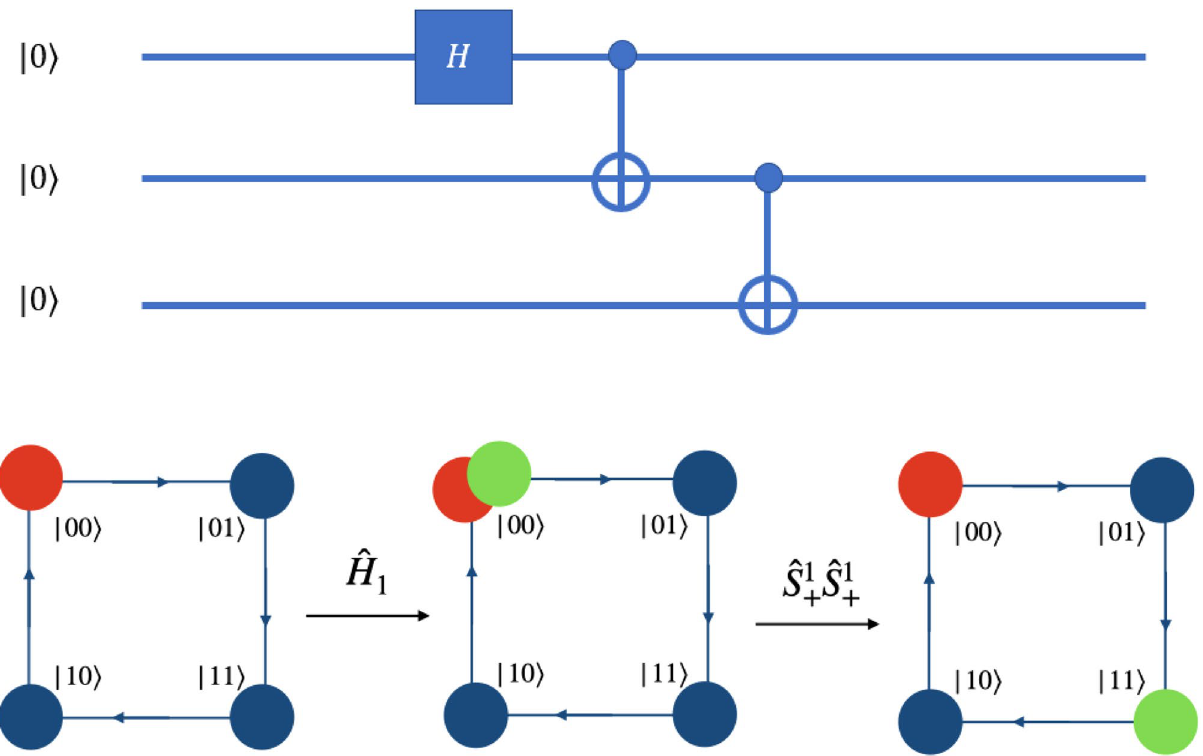
Figure 11. Quantum circuit to create GHZ-state on three qubit system and equivalent quantum walk scheme to obtain GHZ-state is illustrated. Red circle represents real particle. Here the QW-based scheme is more simplified compared to quantum circuit implementation. The 000 (cid:31) input state is and output state is a GHZ-state | � in = | �